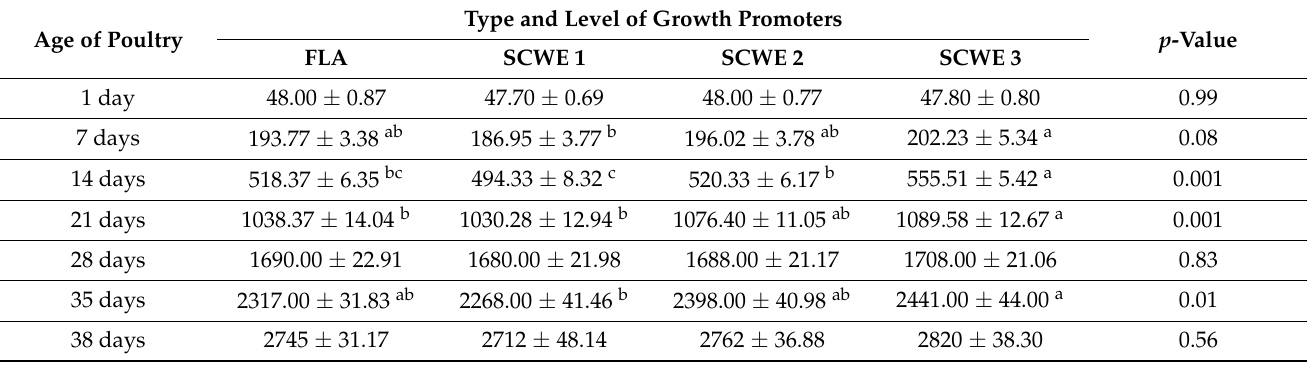
Table 4. Dynamics of live weight (1 head) of broiler chickens (g).